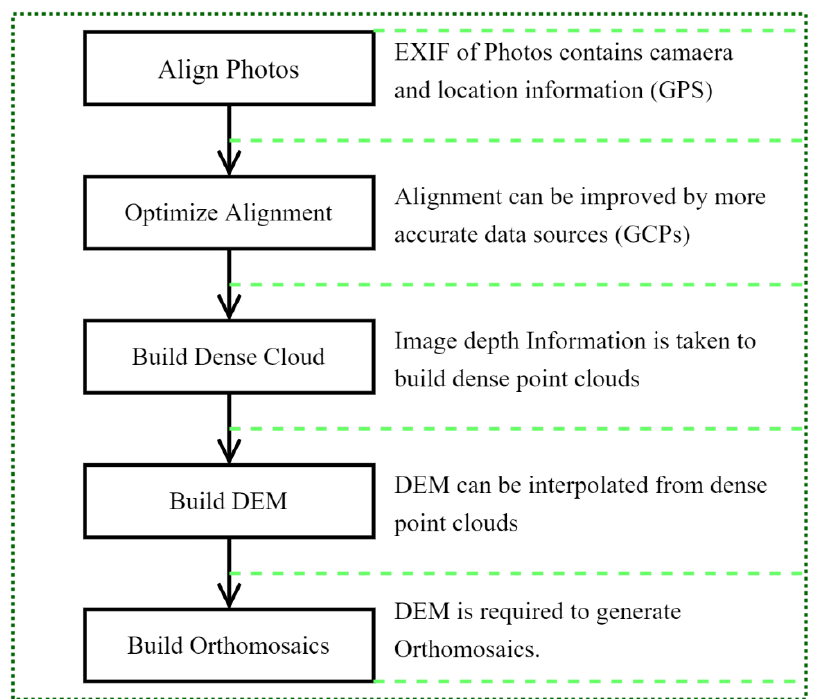
Figure 3. The automated workflow implemented in Agisoft photoscan batch-processing. A Figure 3 . The automated workflow implemented in Agisoft photoscan batch-processing. A batch process accomplishes each task automatically and saves each task on the disk before moving to the next task in the chain.